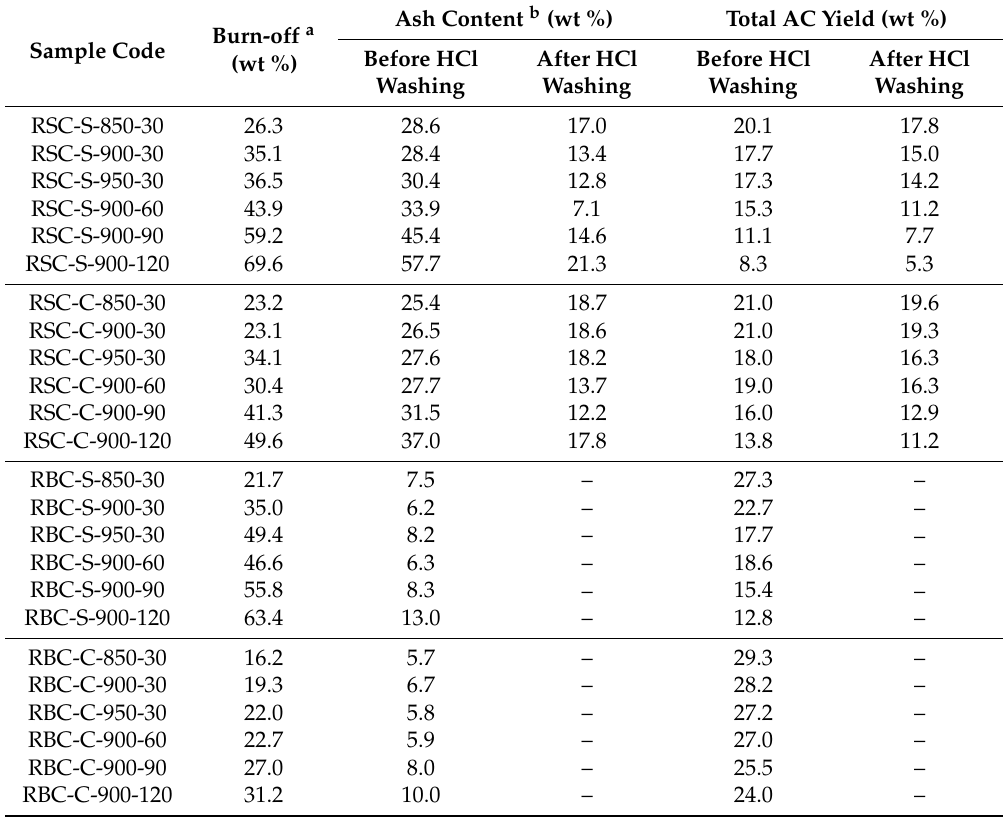
Table 1. Burn-off, ash content and total yield of the activated carbons (ACs) produced from rapeseed cake (RSC) and raspberry seed cake (RBC) using various activation